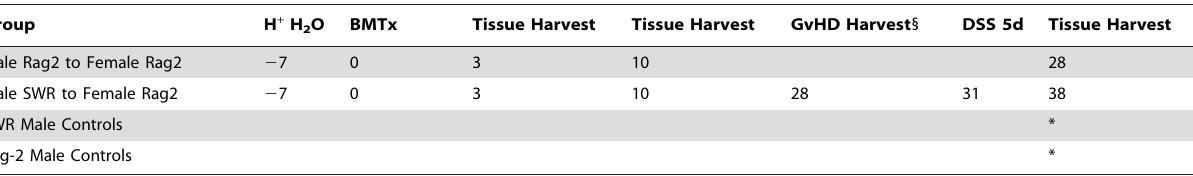
Figure S1 Alignment of twin brightfield and fluorescent images. Colonic section from a Rag2 KO mouse that received